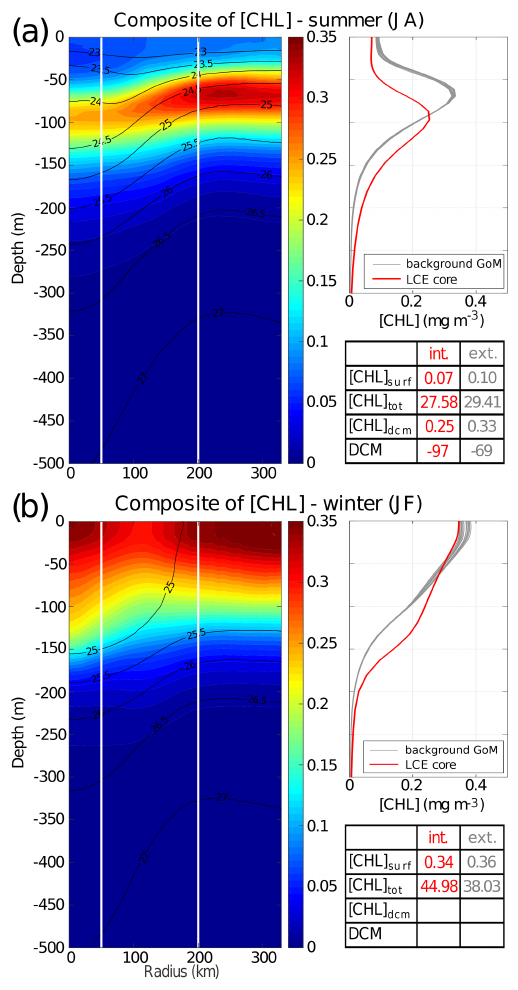
Figure 6. LCE composite transects of [Chl] during summer sea- son (a) and winter season (b) . Density anomalies (black contours) are superimposed. Vertical white lines delimit the three dynami- cal fields of the LCE composite. For each season, [Chl] profiles in the LCE core ( r < 50km, red lines) and in the background GoM (200km <r < 330km, gray lines) are plotted. Key metrics con- cerning [Chl] profiles are also indicated in the